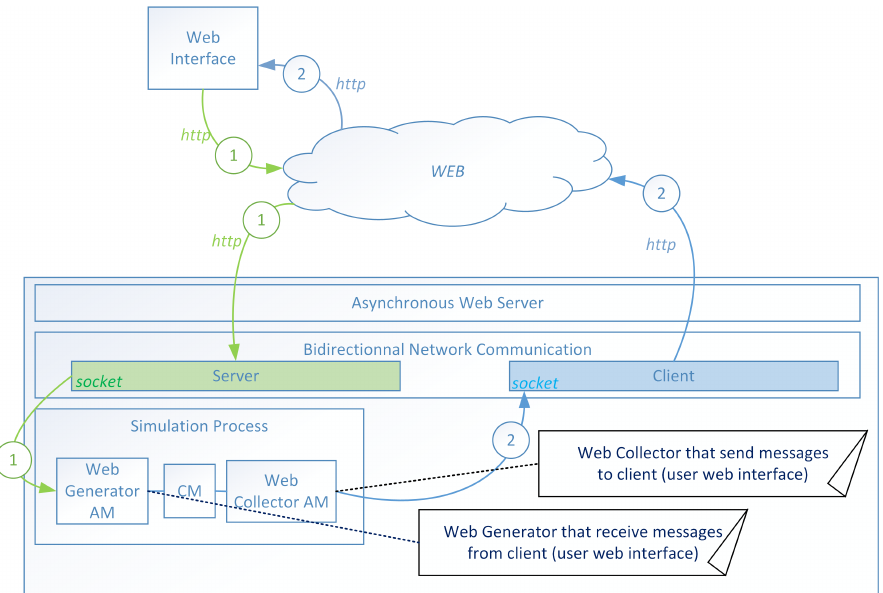
Figure 7. Bidirectional communication between the end-user web app and the simulation process based on the Web Generator and Web Collector DEVS atomic models. (1) Message passing of the input data from the end-user web app to the DEVS coupled model (CM) and (2) the backward simulation results from the Web Collector to the end-user web app.